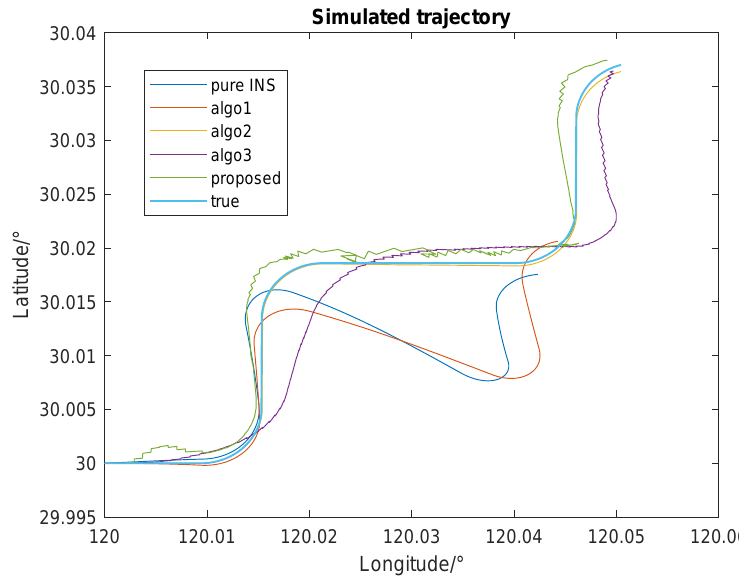
Figure 12. The comparison of trajectories calculated by different